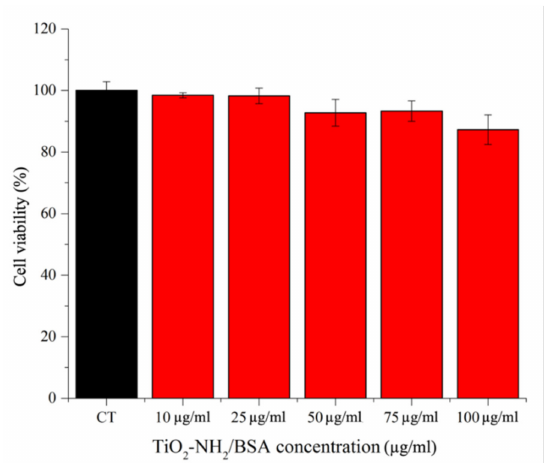
Figure 3. a-TiO 2 -NH 2 /BSA NPs cytotoxicity on Daudi cells incubated with different NPs concen- trations (10, 25, 50, 75 and 100 µ g/mL). Cell viability is measured after 24 h. Bars represent mean percentages of cell viability with respect to the control cells (CT) ± SEMs, n = 3. Similarly, a very high number of positive events, representing cells with a shift in fluorescence intensity with respect to control ones due to the presence of Atto647 labelled NPs which are internalized or attached to the cell surface, are recorded using 25 and 50 µ g/mL of a-TiO 2 -NH 2 /BSA NPs after both 24 h and 48 h of co-incubation with such Daudi cancer cells, as shown in Figure 4. The highest positive events related to such core-shell nanostructures are recorded for the highest concentration used, i.e., 50 µ g/mL, reaching 75.2% ± 2.9 of positive events after 48